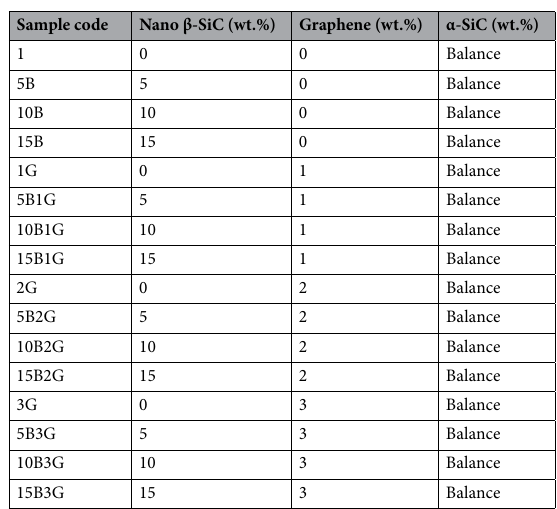
Table 1. Weight percentage of each material and the sample codes.